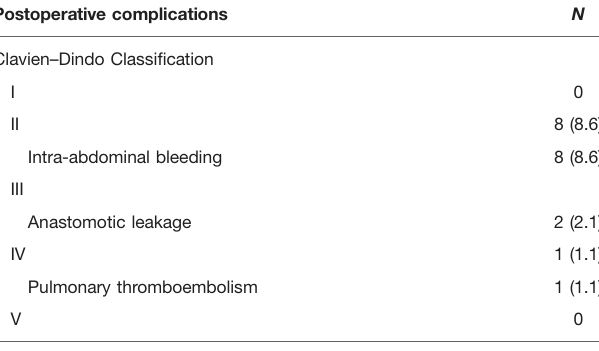
TABLE 3 | Postoperative complications.